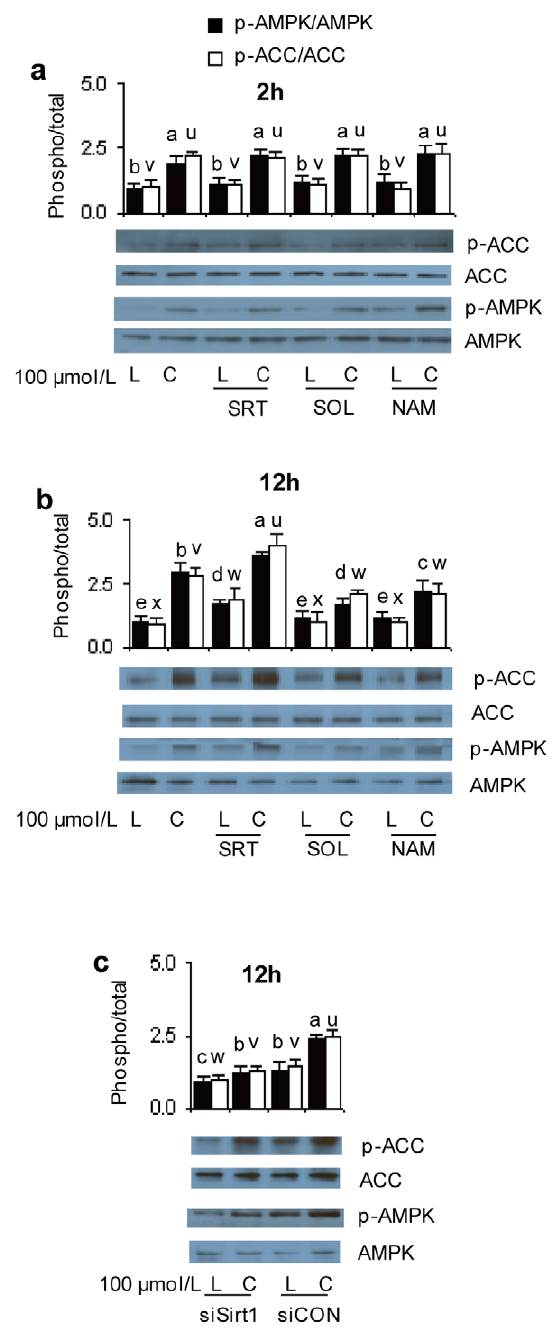
Figure 3. SIRT1 affects ACC and AMPK phosphorylation levels after t 10 c 12 CLA treatment. Differentiated 3T3-L1 adipocytes were incubated with 100 m mol/L LA (L) or t 10 c 12 CLA (C): a with or without SIRT1 activator SRT1720 (SRT), or sirtuin inhibitors sirtinol (SOL) or nicotinamide (NAM) for 2 or b 12 h; or c with 40 nmol/L of SIRT1 siRNA (siSIRT1) or control siRNA (siCON). Representative western blots indicate the proteins detected in cytosolic extracts with antibodies to p-ACC (p- Ser79), or total ACC, p-AMPK (p-Thr172), or total AMPK. Each bar in panels a–c represents the mean + SEM (n=3) of the ratio of the phosphorylated to total form of each protein (phospho/total) for three independent experiments. Means for p-AMPK/AMPK (a–e) or p-ACC/ ACC (u–x) not sharing a common letter differ, P ƒ